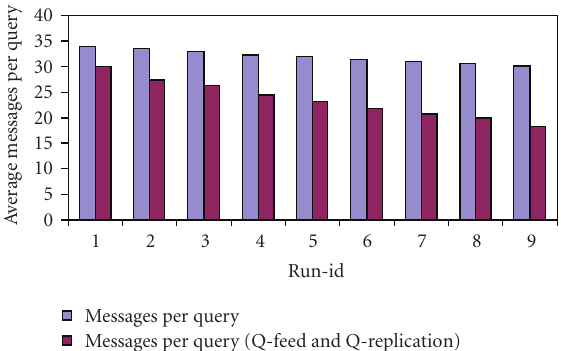
Figure 6: The nodes in di ff erent status.